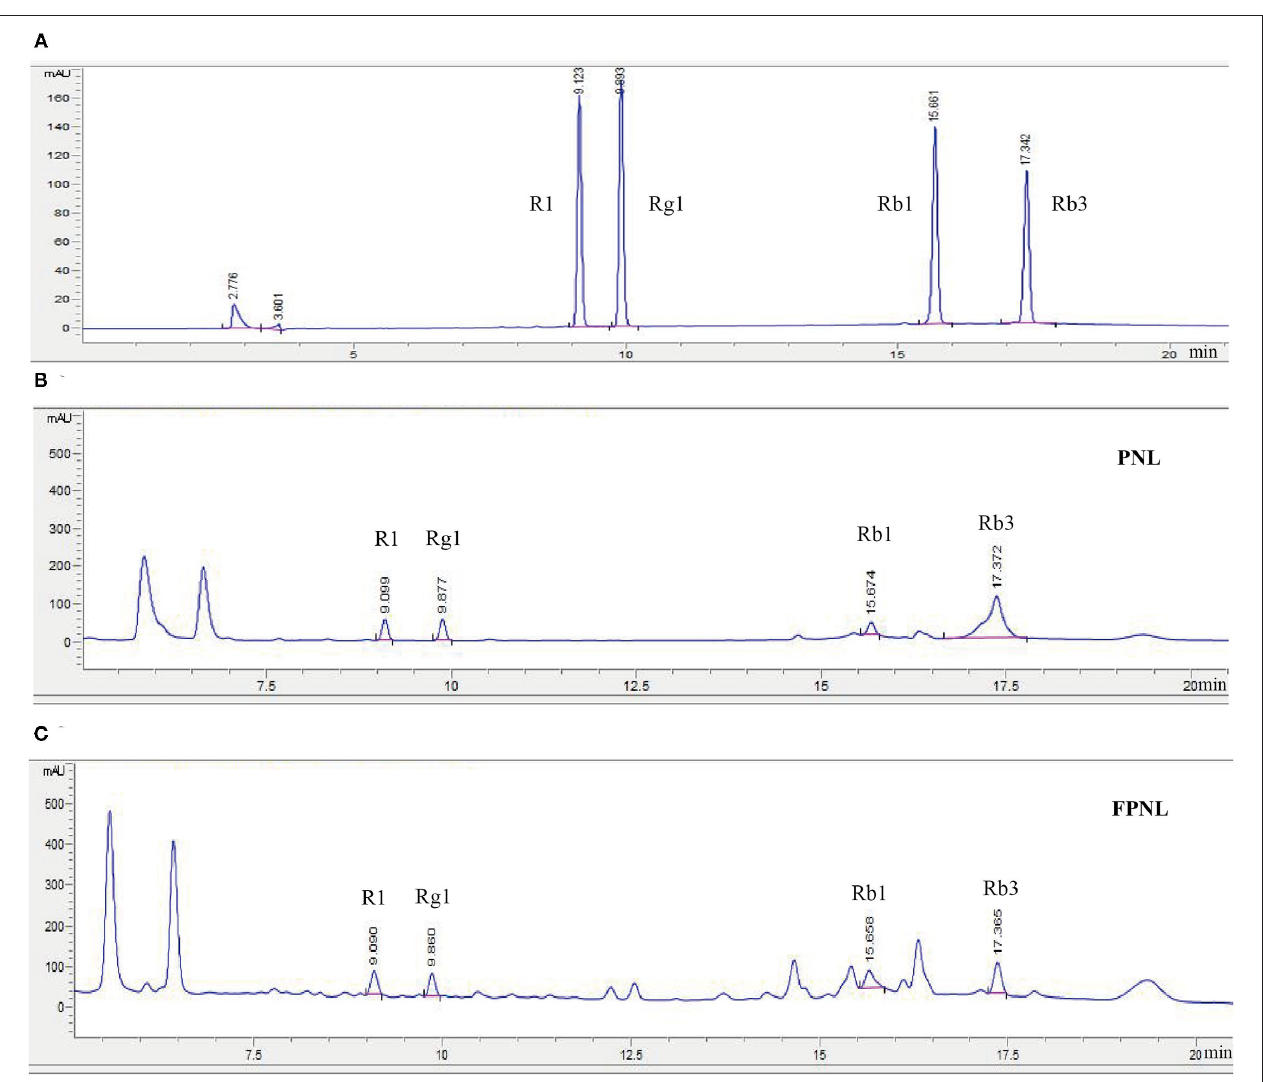
FIGURE 1 | HPLC analysis of different saponins content in PNL and FPNL. (A) A stander mixture of four saponins. (B) The four saponins in PNL. (C) The four saponins in FPNL.